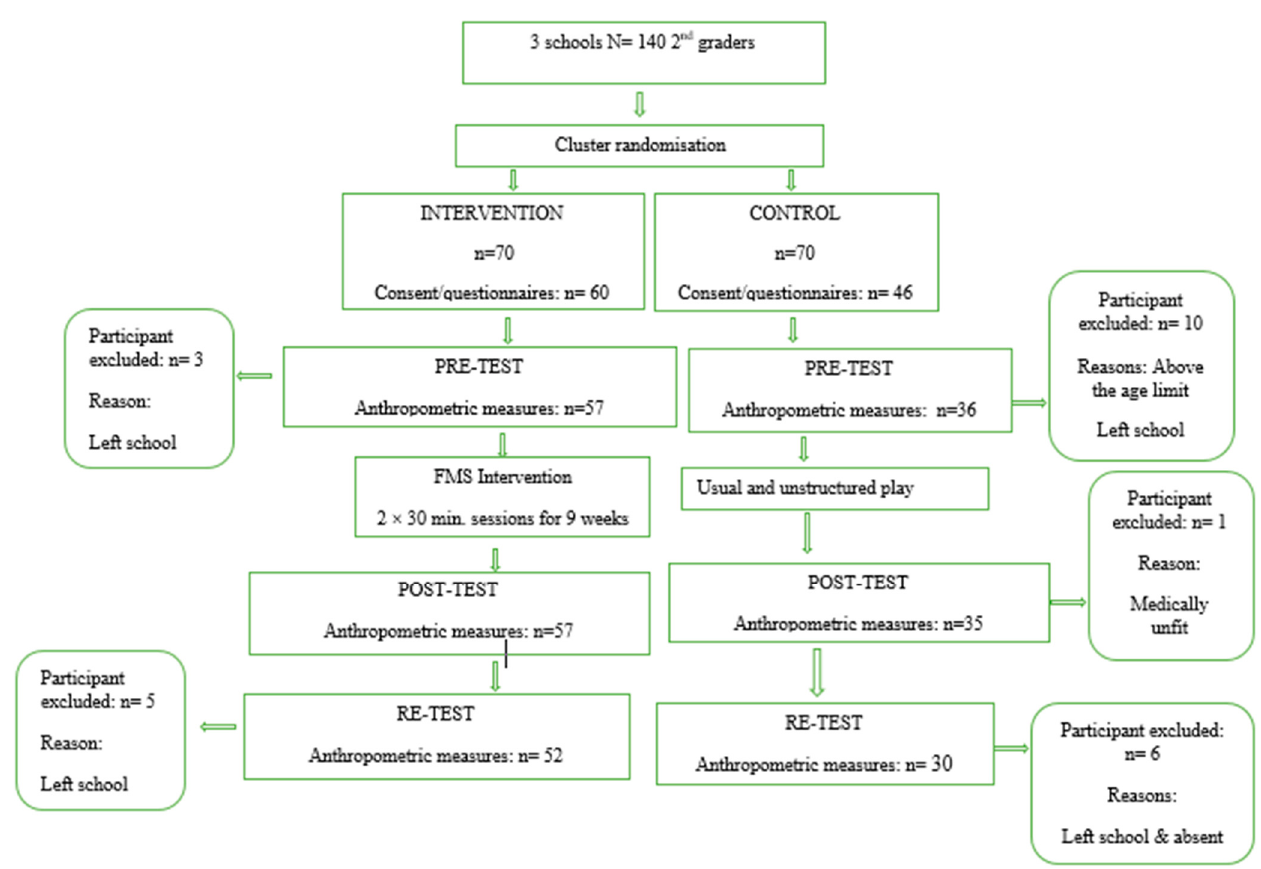
Figure 1. Flow diagram of recruitment, randomization and participation of school children in the study.